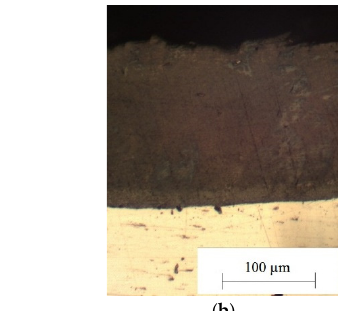
Figure 5. Microstructure of the nitrided layer on a specimen from steel 12X18H10T: ( a ) a specimen made by conventional method, layer depth 0.19 mm, microhardness 1251 HV5; ( b ) LB-PBF speci- men, dark field image, layer depth 0.16 mm, microhardness 1352 HV5.